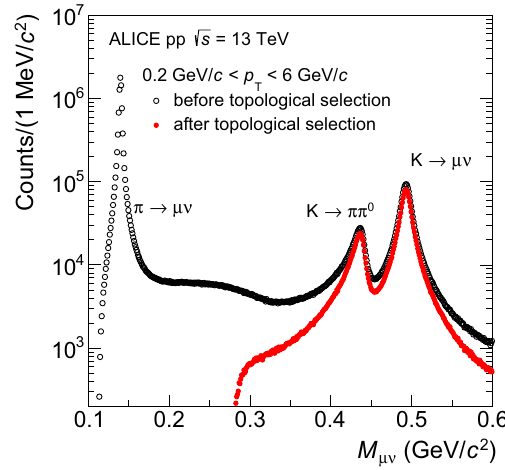
Fig. 2 Kink invariant mass distribution for charge summed particles in the mother particle transverse momentum interval 0 . 2GeV / c < p T < 6GeV / c , before (open circle) and after (full circle) topological selec- tions